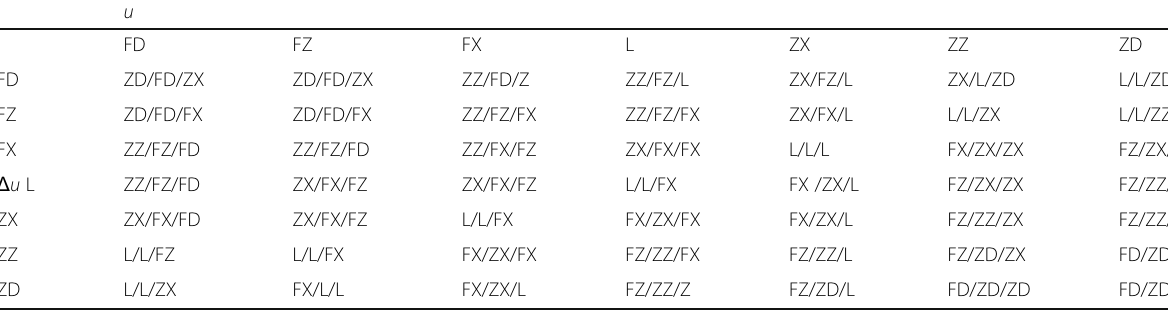
Table 1 Fuzzy rules of the three nonlinear functions f P (·), f I (·), and f D (·)